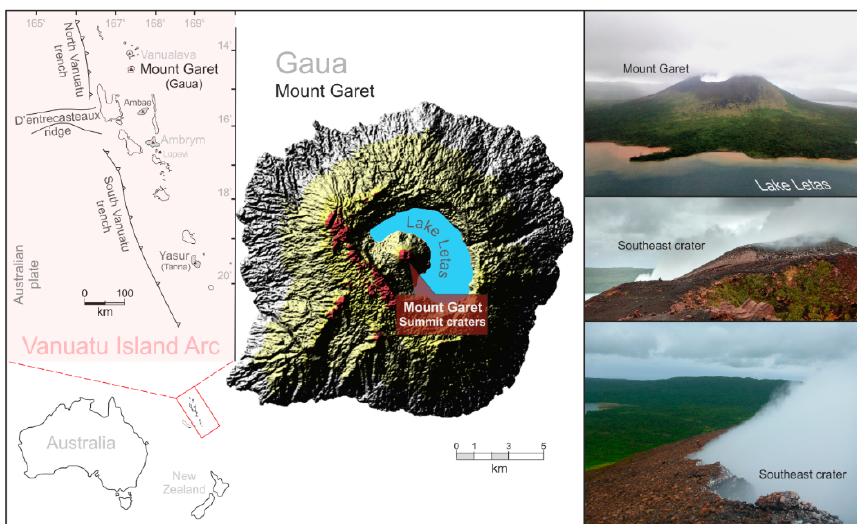
Figure 1. On the left: illustration of the overall tectonic context of the Vanuatu Island Arc, with currently active volcanoes and their location marked in red triangles. In the center: digital elevation model (DEM) of the island of Gaua; land features above 700 m (a.s.l.), including Mount Garet’s summit crater, are highlighted in red. On the right: photos of Mount Garet and its currently degassing southeast crater (December 2019); photos of National Geographic property.